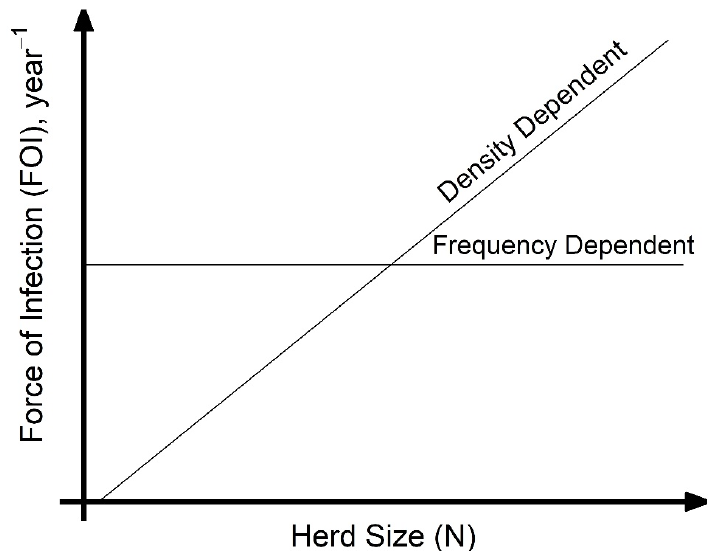
Figure 1. Schematic representation of the two force of infection (FOI) trajectories for two transmission pattern types with increasing household herd size (N), the count of infected hosts (I), and transmission rate β for Peste des petits ruminants virus at endemic equilibrium: density ‐ dependent transmission where FOI = ( β × N) × (I/N) = β × I, and frequency ‐ dependent transmission where FOI = ( β ) × (I/N). Arbitrary values were used in the plot to display expected patterns for each contact rate assumption for comparison with SEEDZ data.